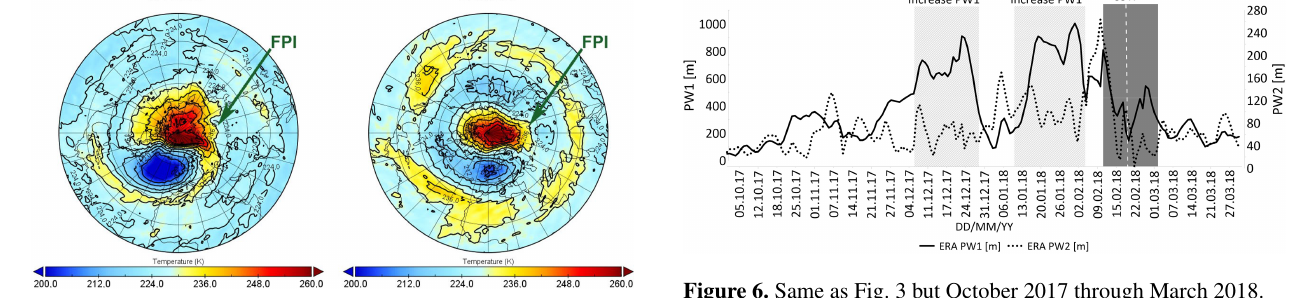
Figure 4. Distribution of temperature at 10hPa in stereographic projection at the SSW maximum. Green arrow shows the FPI lo- cation.